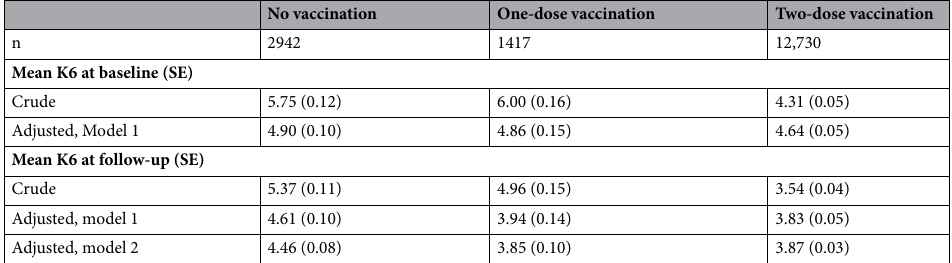
Table 2. Mean K6 scores in total participants (n = 17,089) according to COVID-19 vaccination status, 2021, JACSIS, Japan. Model 1: adjusted for sex, age, education, occupation, living arrangements. Model 2: adjusted for sex, age, education, occupation, living arrangements, baseline K6, baseline vaccine hesitancy, frequency of outings at follow-up, frequency of voice chatting at follow-up, fear of COVID-19 scores at follow-up, and